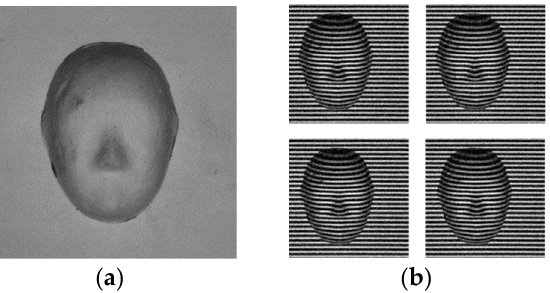
Figure 4. Measured data of “face” model: ( a ) Measured object; ( b ) A set of deformed patterns. The reconstructed deformed patterns are shown in Figure 5, Figure 5a is 𝐼 (cid:4593)(cid:4593) (cid:2869)(cid:2869) , and it is regarded as a reference frame. The process of pixel matching is in Figure 5a,b. The points marked in Figure 5a are the selected feature points of 𝐼 (cid:4593)(cid:4593) (cid:2869)(cid:2869) , the other points marked in Figure 5b are the matching points of 𝐼 (cid:4593)(cid:4593) (cid:2869)(cid:2872) . The difference between the two set of points represents the movement of the “face”. Then the estimated motion matrix, blur matrix and down-sampling matrix are used for subsequent iterations. In this experiment, the super-resolution factor q is 2, the max number of iterations m is 200. Figure 5c,d are the reconstructed results of the averaging method and MAP, respectively, and their pixel size is 512 × 512. By comparison, it can be seen that the deformed pattern reconstructed by MAP is clearer, and there is no large motion blur. At the same time, compared with the original low-resolution deformed pattern, the deformed pattern reconstructed by MAP has a good effect on noise suppression. Figure 5e,f are the enlargements of the rectangular areas of Figure 5c,d, respectively. Compared with Figure 5e, Figure 5f has a clearer edge, which further indicates that noise is reduced effectively using MAP.